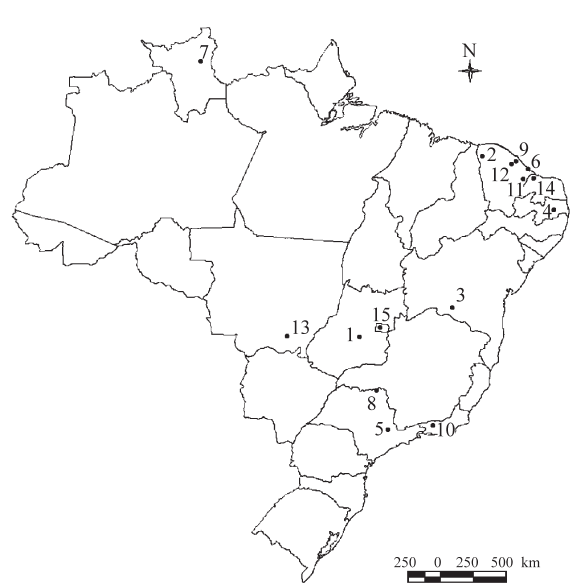
Figure 1 - Map of Brazil indicating the localities where Bemisia individu- als were collected. Map numbers correspond to the populations indicated in Table